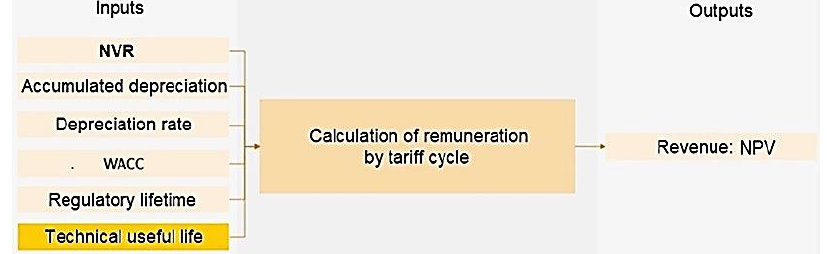
Figure 2. Variables used for calculating revenue via the net present value (NPV) [authors].